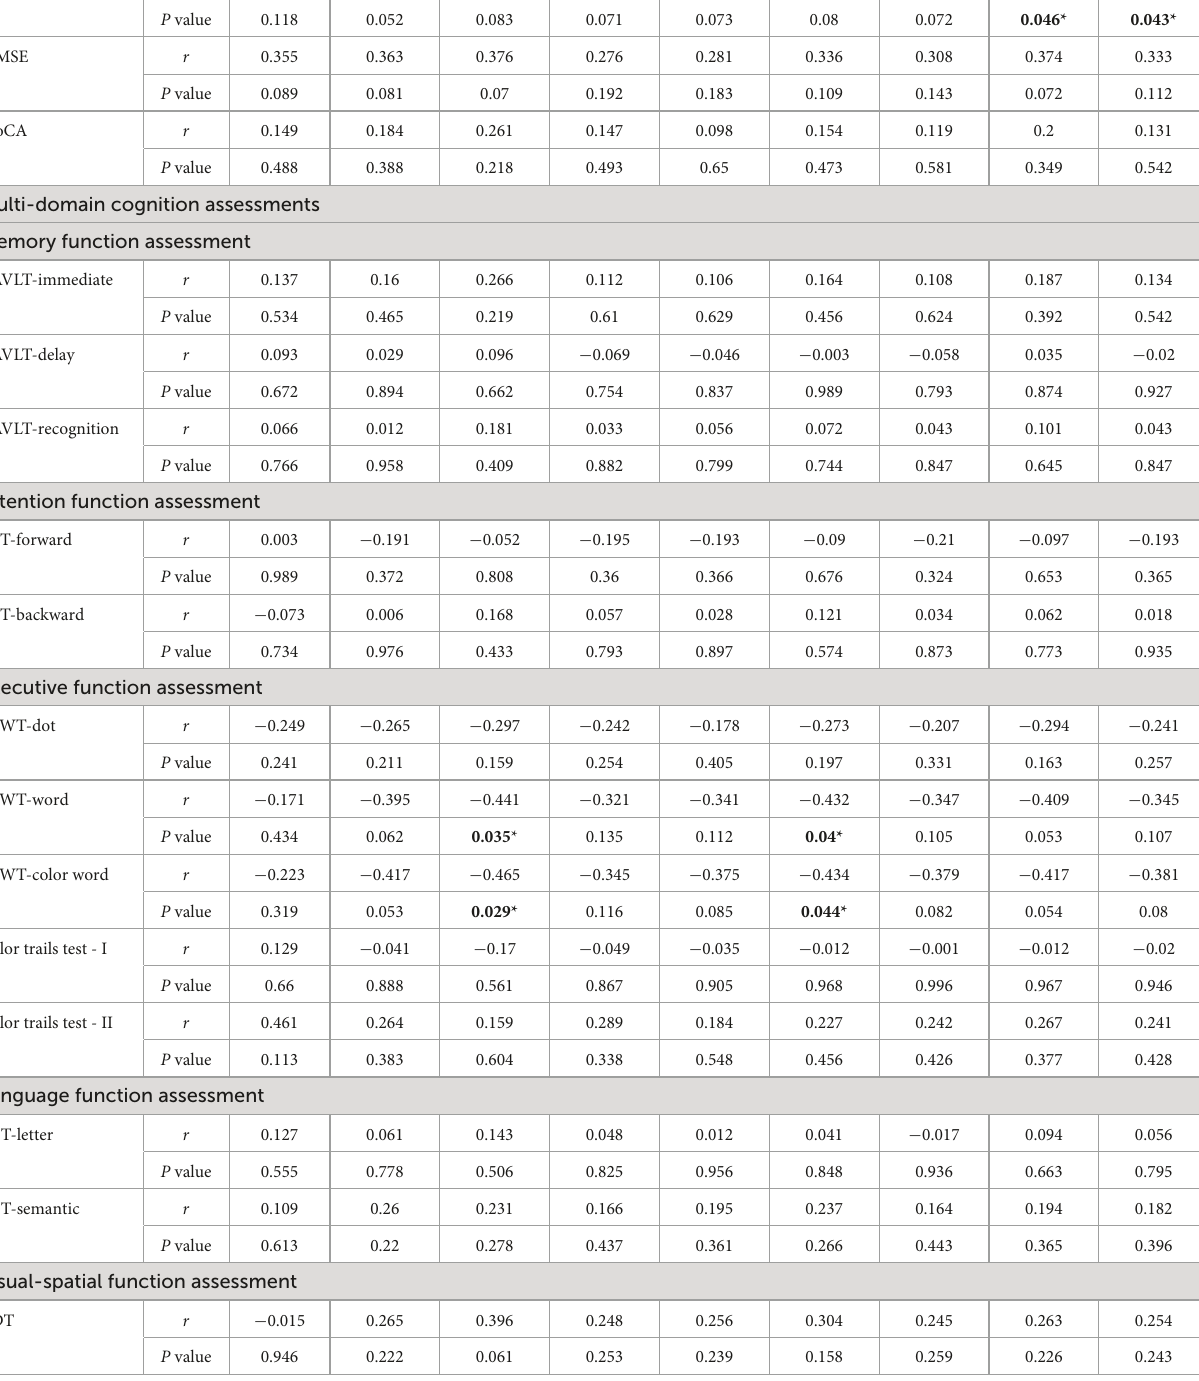
TABLE 6 Partial Spearman correlation analysis of cognitive function and macular thickness in mild AD group with adjustment for age, gender, education, and hypertension. Fovea